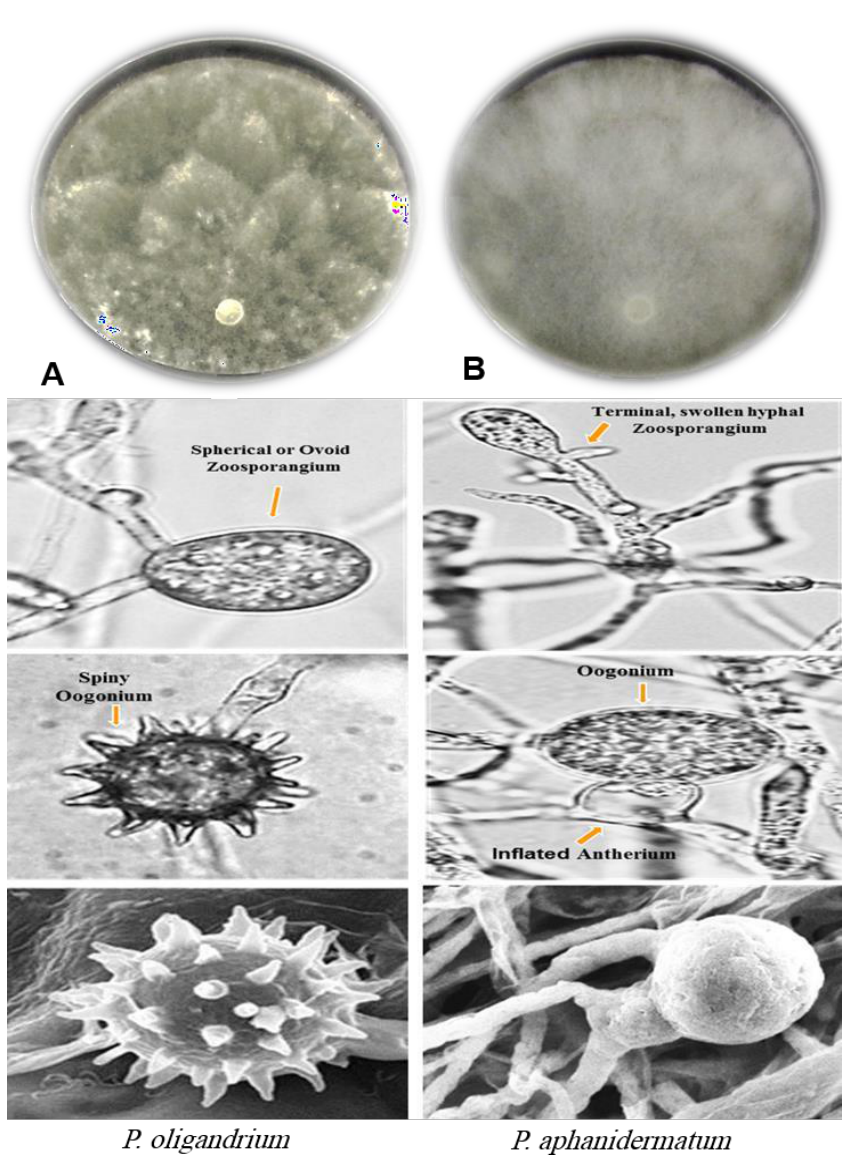
Figure 1. Morphological characterizations of Pythium isolates on PDA, light, and scanning electron microscope. ( A ) P . oligandrum and ( B ) P . aphanidermatum Table 1. The reduction in mycelial growth of the pathogenic P. aphanidermatum by P. oligandrum isolates (MS15, MS19 , and MS31).